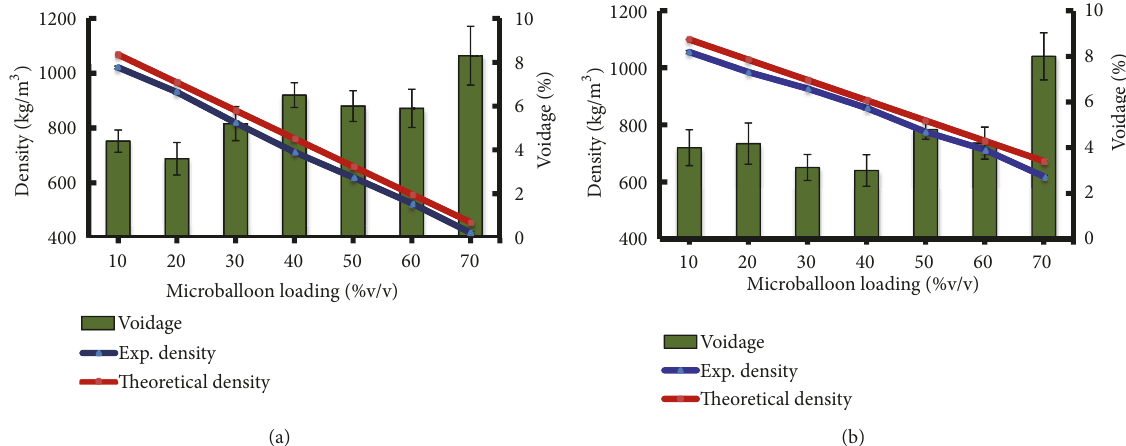
Figure7:Theoreticalandexperimentaldensitiesofsyntacticfoamspecimens:(a)SF15and(b)SF46.Thevoidageispresentedinthesecondary